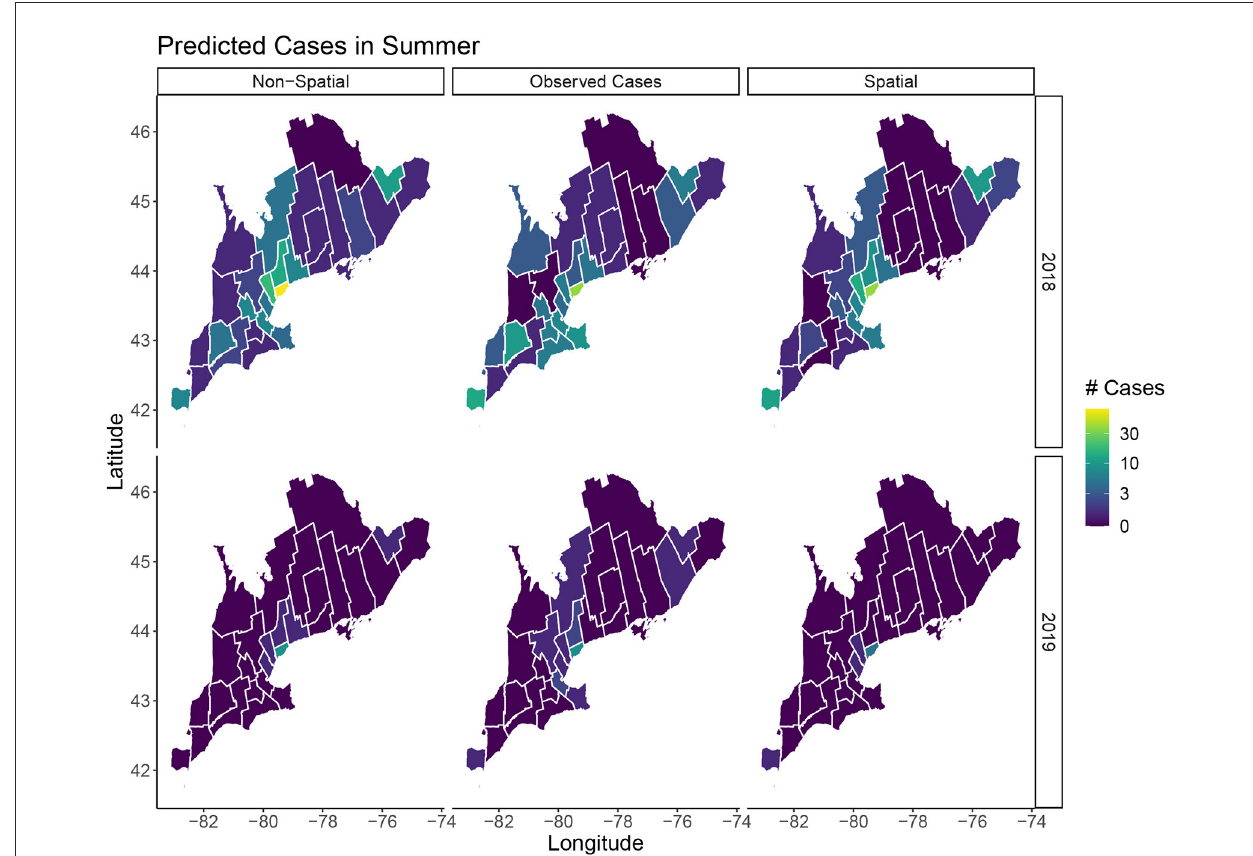
FIGURE6 Predicted cases in July, August, and September for 2018 and 2019. The left column shows the median predicted number of cases in the non-spatial model, the center column is the true observed cases, and the right column shows the median predicated cases in the spatial